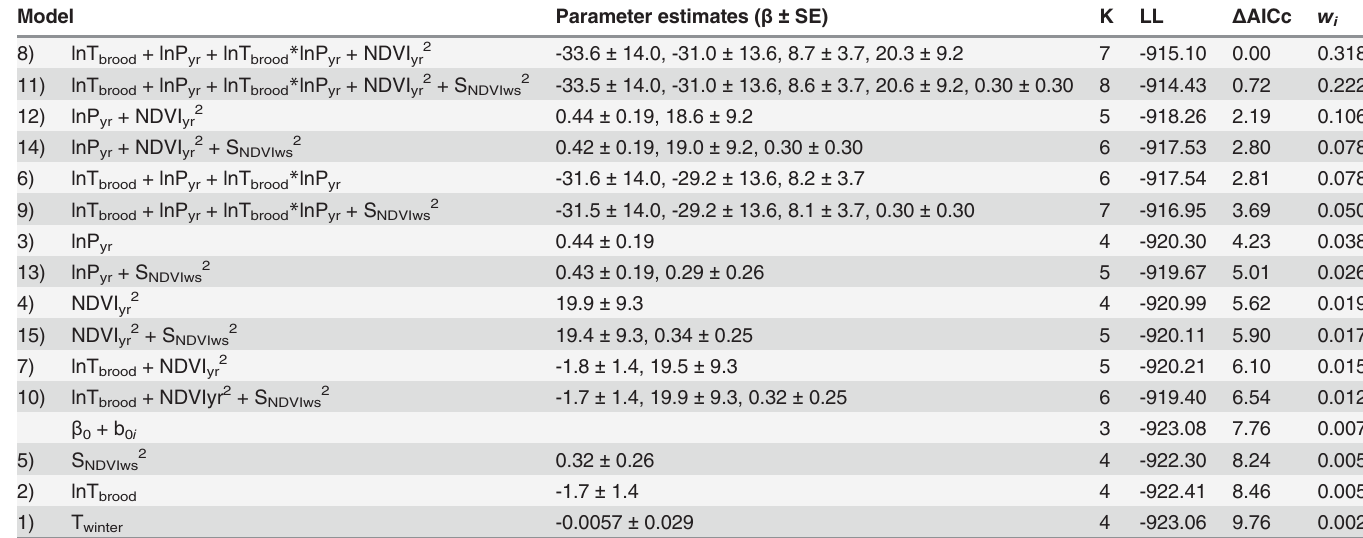
De fi nitions of factors are in Table 2 and descriptions of hypotheses are in S2 Appendix. The intercepts-only model ( β 0 + b 0 i ) is included for comparison. Slope estimates and SE for S NDVIws were multiplied by